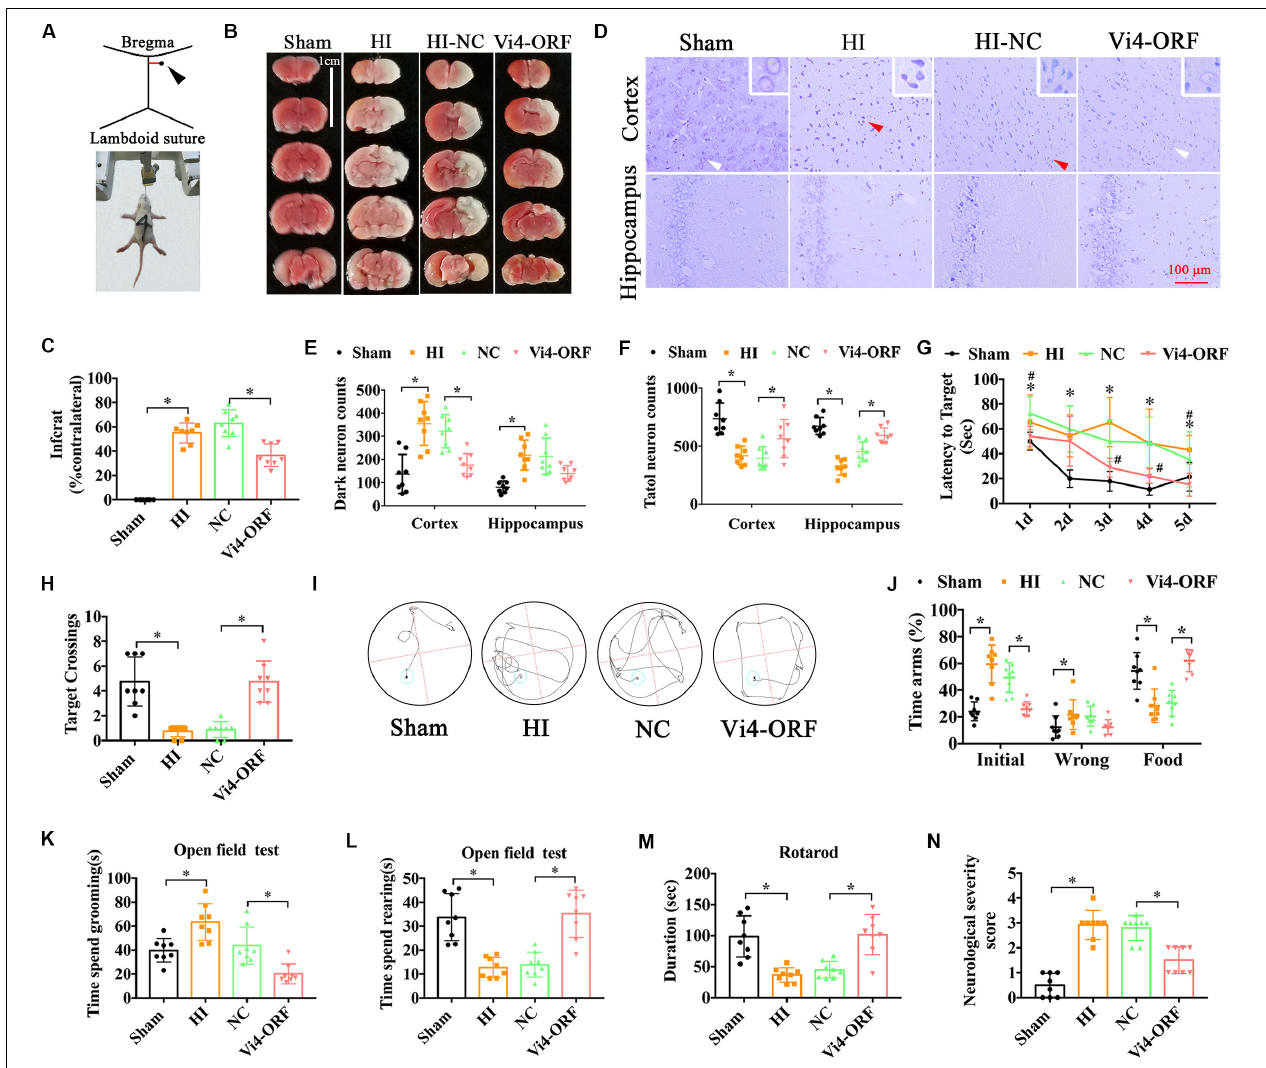
FIGURE 2 | The neurobehavioral tests of rats after intraventricular injection of Vi4-ORF in vivo . (A) Coordinates of the right ventricle for the Vi4-ORF injection in the P3 rats. (B) TTC staining among the sham, HI-NC and Vi4-ORF groups at 24 h after HI. Scale bar = 1 cm. Pale white represents the infarct area, red shows the normal staining. (C) Quantitative histogram for the infarct ratio (% contralateral) between NC and Vi4-ORF groups, n = 8/group. (D) Nissl staining in the groups of sham, HI-NC and Vi4-ORF. The white arrow represents surviving neurons. The red arrow represents dark neurons. Scale bar = 100 µ m. (E,F) The number of dark neuron and total neuron in cortex and hippocampus among sham, HI, NC and Vi4-ORF groups, n = 8/group. (G) The latency to target during 5 days training among the sham, HI, NC, and Vi4-ORF groups at 1 month after HI in MWM test. * P < 0.05 vs. Sham. # P < 0.05 vs. NC, n = 8/group. (H) Target crossings in MWM test at 1 month after HI, respectively. (I) The walking path of the platform in probe trial of Morris Water Maze test at day 5 of 1 month after HI. (J) The time arms (%) of initial, wrong and food arms in the sham, HI, NC and Vi4-ORF groups at 1 month after HI in the Y-maze test, n = 8/group. (K,L) The time spent grooming and rearing in the open field experiment 1 month after HI, n = 8/group. (M) The duration of rats on rotary bar in the rotarod test 1 month after HI, n = 8/group. (N) NSS score among the sham, HI, NC and Vi4-ORF groups 1 month post HI, n = 8/group. The N number is the number of biological repeats. HI, hypoxia-ischemia; NC, negative